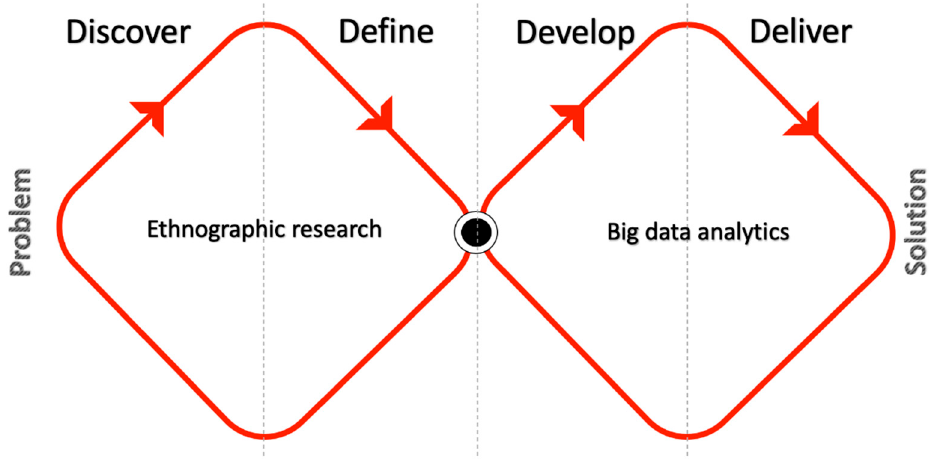
Figure 1. The overarching methodological framework adapted from the British Design Council [47].